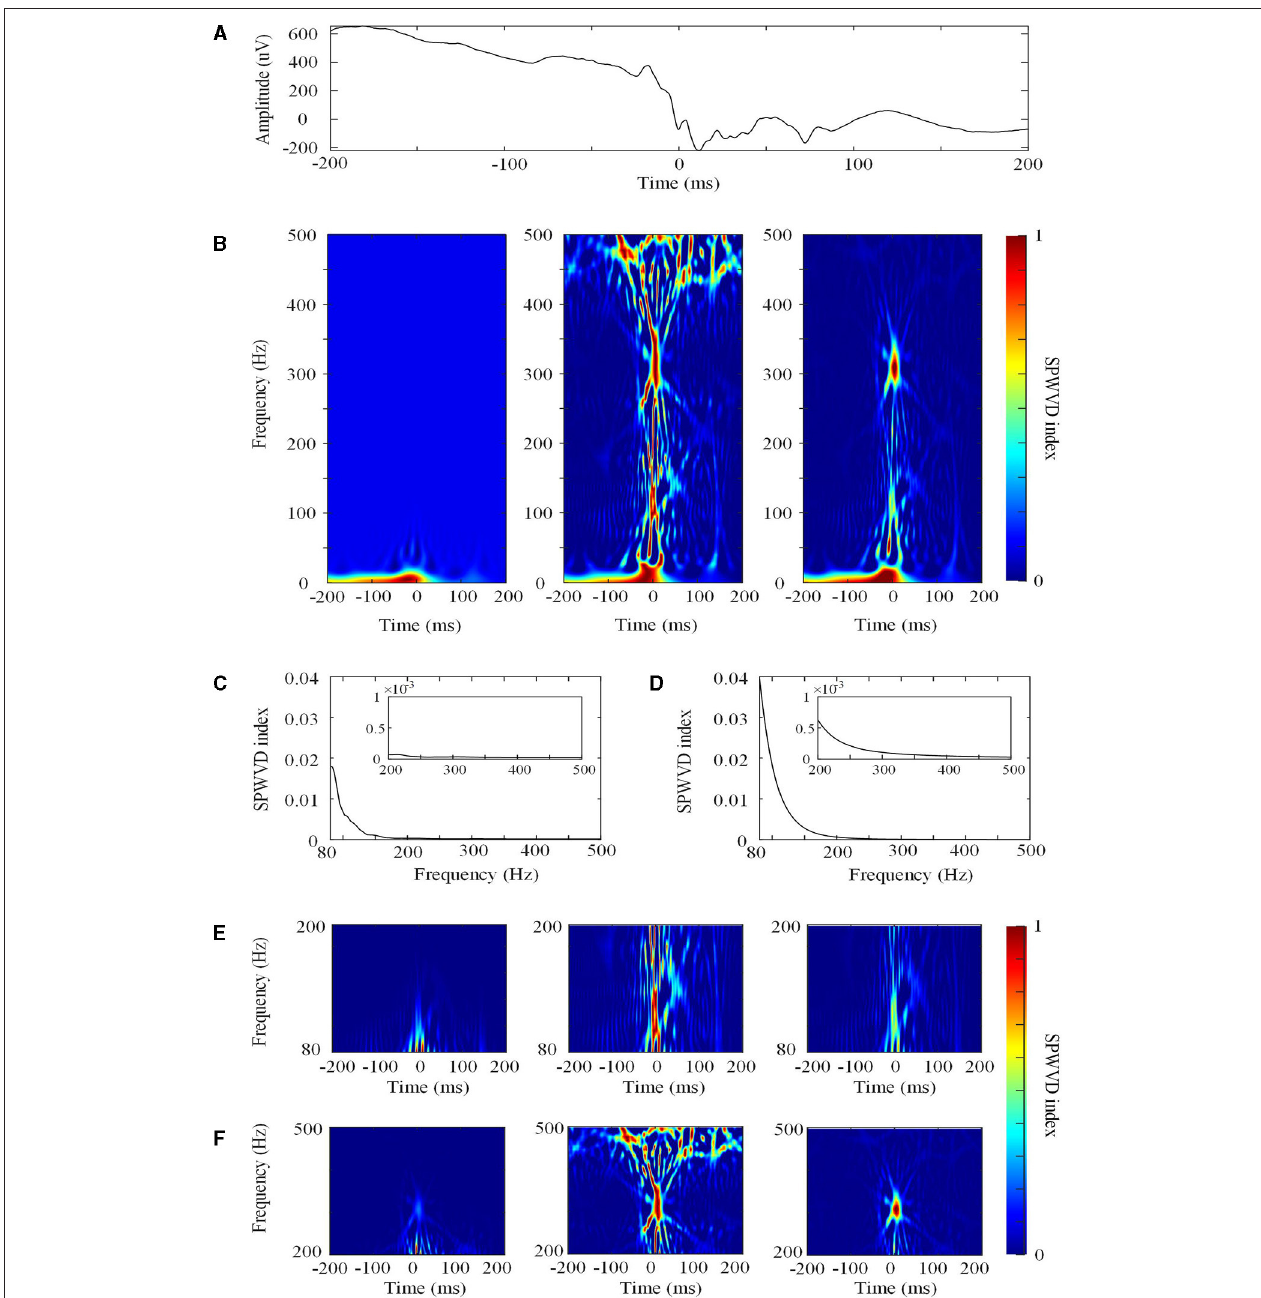
FIGURE 2 | The smoothed pseudo Wigner–Ville distribution (SPWVD). (A) The original waveform of a 400ms epoch. (B) Left: the first normalization of the SPWVD transformation (0–500Hz). In this figure, all of the SPWVD transformation values are normalized by dividing all time points by the maximum SPWVD value. The normalized value ( ˆ W tf ) is the SPWVD index. Middle: Re-normalized SPWVD. The ˆ W tf in the left is re-normalized by dividing all time points in each HFO by the maximum SPWVD index in all frequencies. Right: Adjusted SPWVD (ASPWVD). The ˆ W tf in the left were adjusted by dividing all HFOs time points by the median maximum SPWVD index. (C) Curve C for re-normalized SPWVD. This is curve C for this epoch from 80 to 500Hz. The small rectangle in the figure is the enlargement of curve C for FR (200–500Hz). (D) Curve C for the ASPWVD. This is curve C with the median maximum SPWVD index for all epochs from 80 to 500Hz. The small rectangle in the figure is the enlargement of curve C for FR (200–500Hz). (E) Ripple (80–200Hz) SPWVD spectrum images. Left: the first normalization of the SPWVD spectrum image. Middle: Re-normalized SPWVD spectrum image. Right: the ASPWVD spectrum image. (F) FR (200–500Hz) SPWVD spectrum image. Left: the first normalization of SPWVD spectrum image. Middle: Re-normalized SPWVD spectrum image. Right: the ASPWVD spectrum image. (E,F) indicate that the ASPWVD spectrum image provides higher time frequency resolution and less noise than the re-normalized SPWVD.